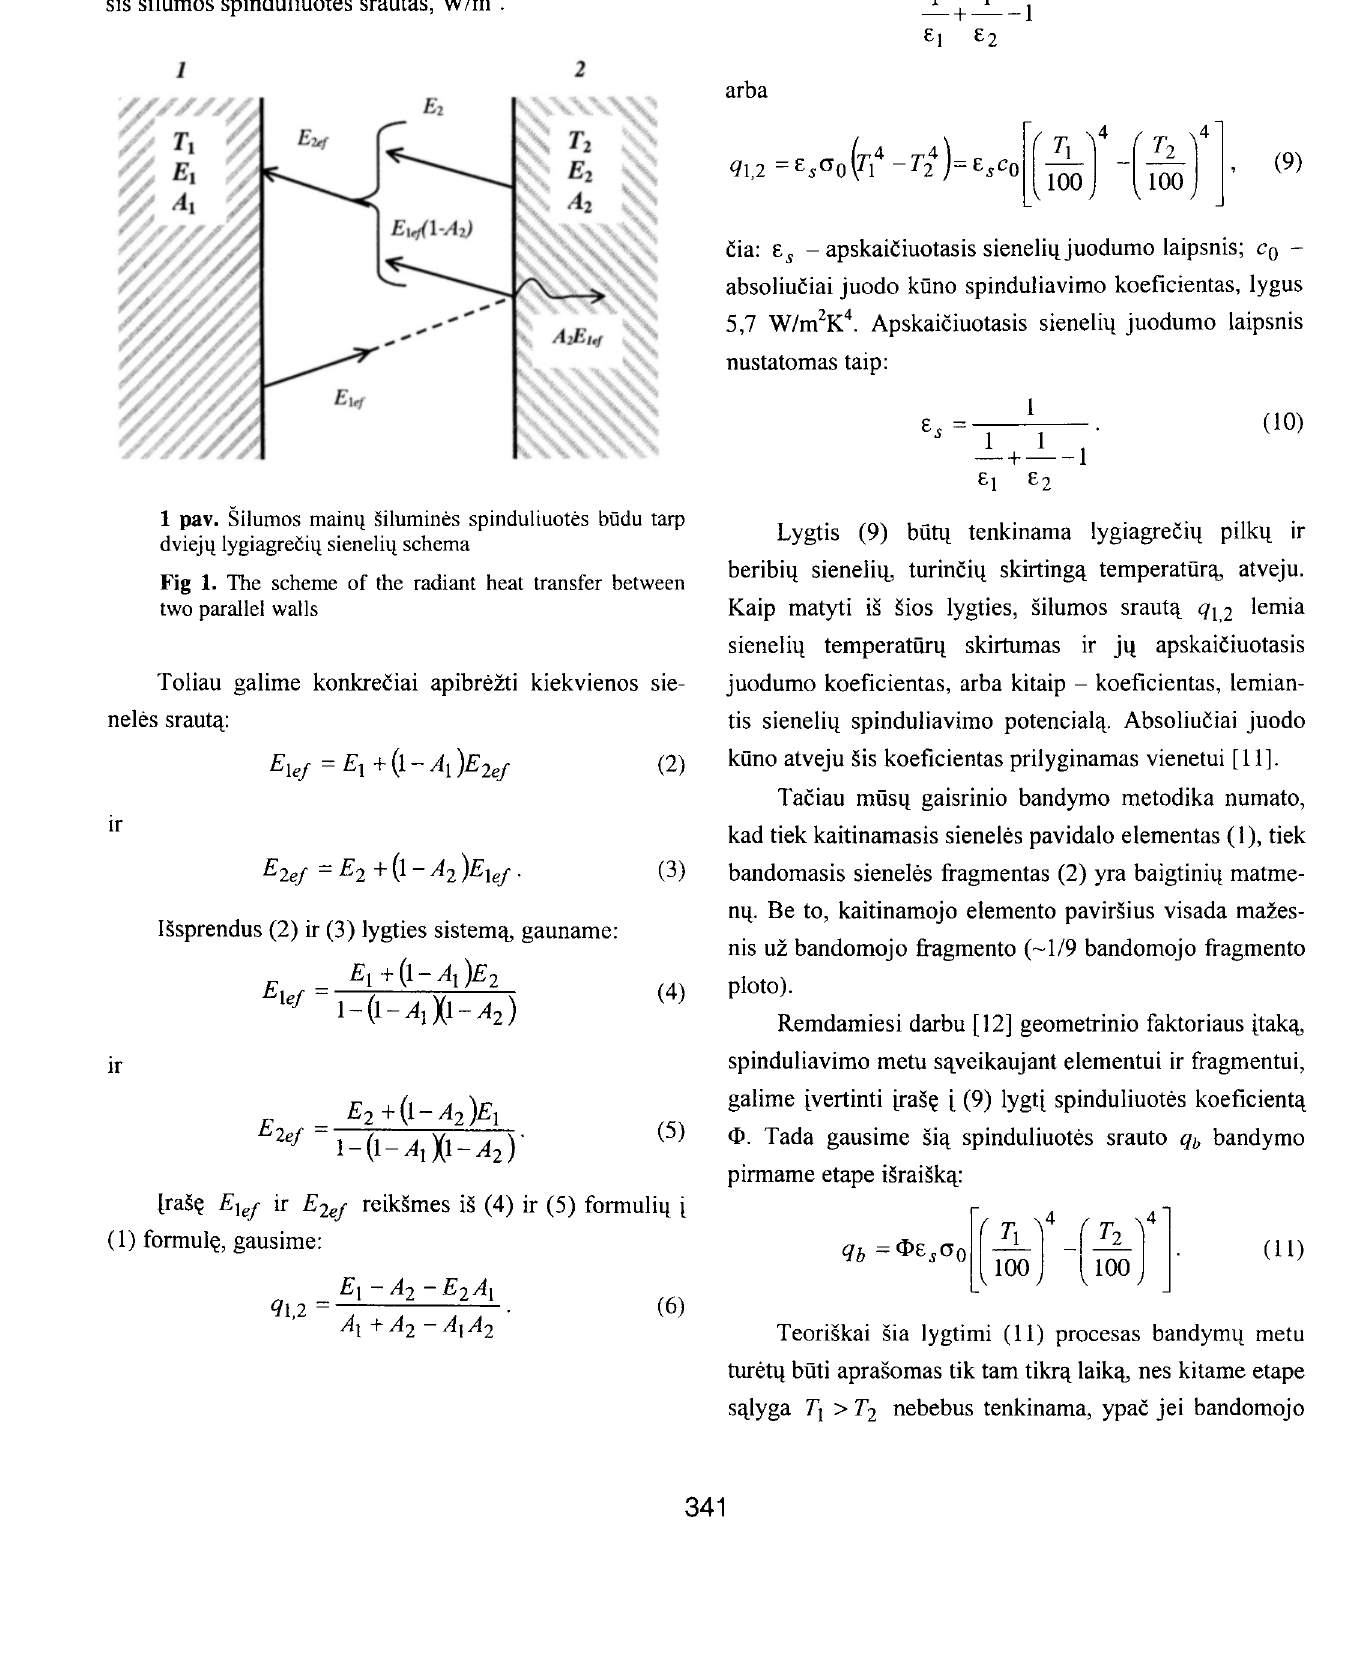
Fig 1. The scheme of the radiant heat transfer between two parallel walls Toliau galime konkreciai apibretl:i kiekvienos ste neles srautct: